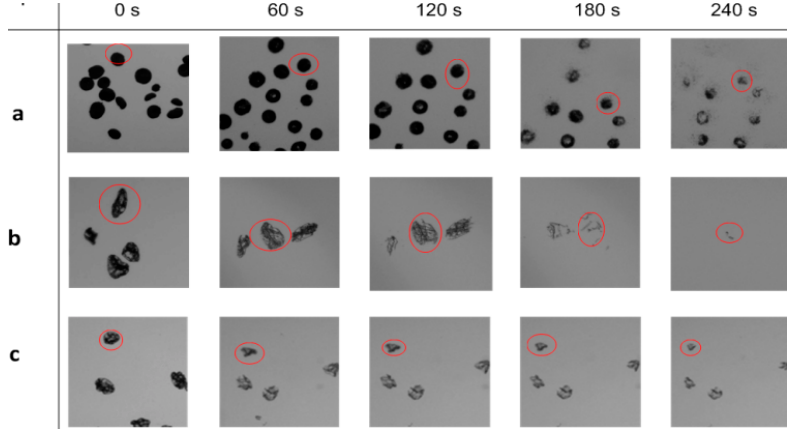
Figure 9. Time-lapse tracking photographs of dissolution behaviors in PBS solutions of the lysine- loaded microparticles obtained with an ethanol/water solvent of 4:1 volume ratio at a drying temperature of 100 ( a ); 155 ( b ); and 205 °C ( c ), respectively.